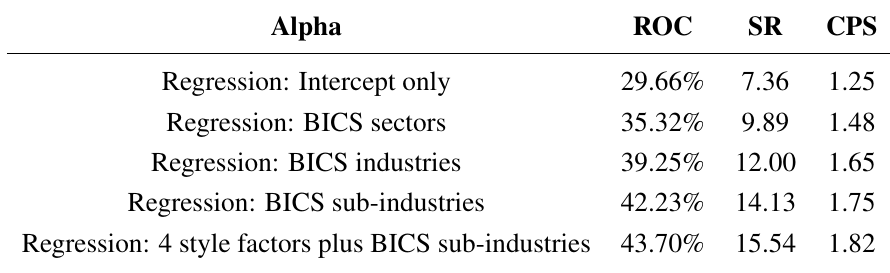
Table 2. Simulation results for the 5 alphas via bounded regression discussed in Section